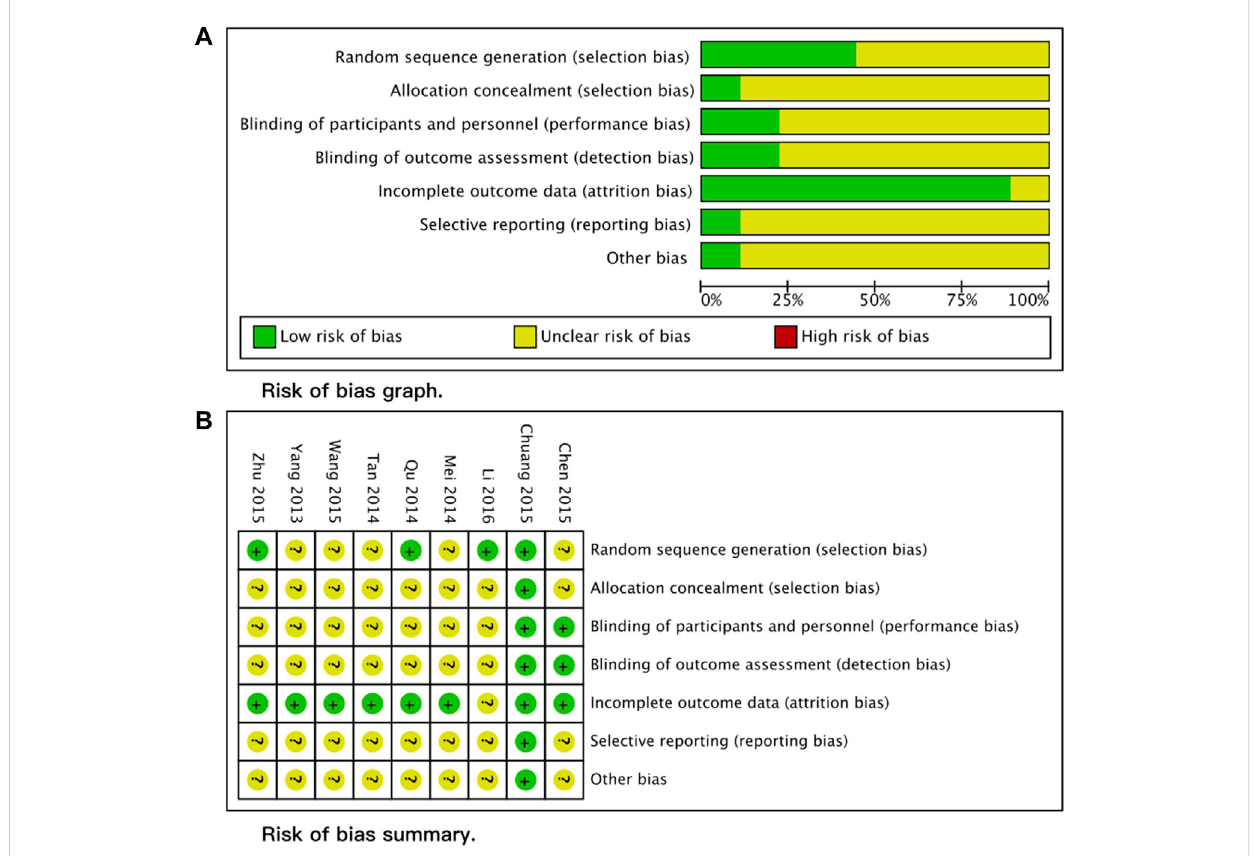
FIGURE 2 Risk of bias assessment (A) Risk of bias graph. (B) Risk of bias summary.